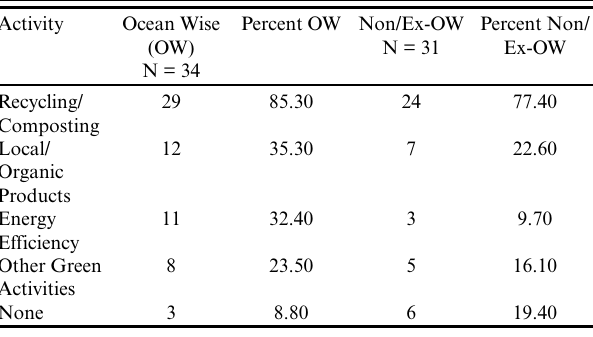
Table 1 . Green activities taking place at